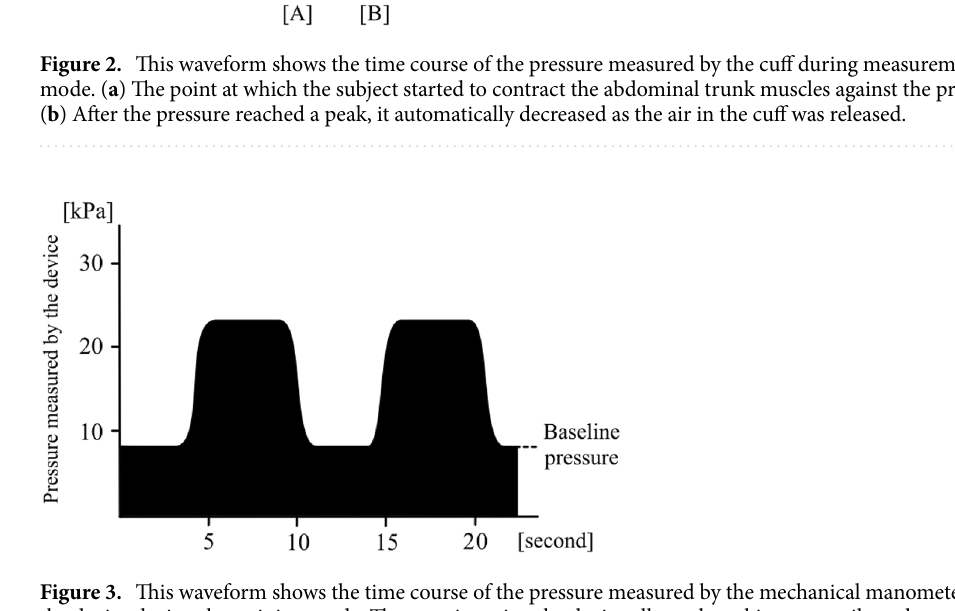
Figure 3. This waveform shows the time course of the pressure measured by the mechanical manometer in the device during the training mode. The exercise using the device allows the subjects to easily and powerfully contract the abdominal trunk muscles under the baseline pressure. During the exercise, the device displays the abdominal muscle strength in real-time as a waveform and a numerical